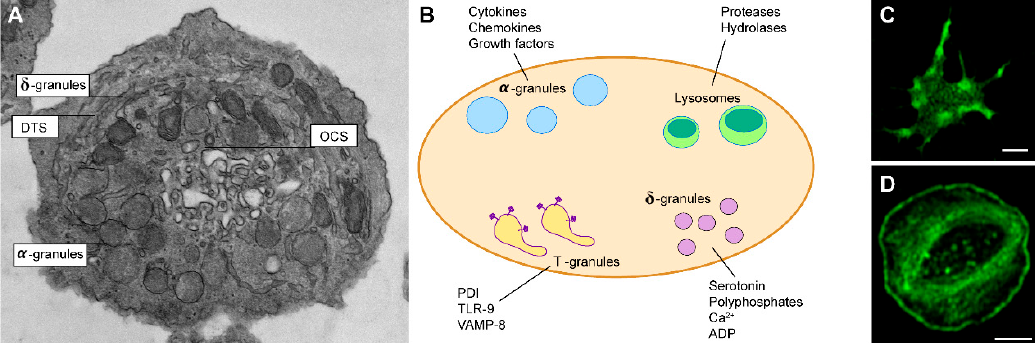
Figure 1. ( A ) Electron micrograph of resting platelet. Indicated: open canalicular system (OCS), dense tubular system (DTS), α -granules, δ -granules that contain small molecules. ( B ) Graphical representation of the main secretory granules of platelets and their contents. Indicated: protein disulfide isomerase (PDI), with toll-like receptor 9 (TLR), vesicle-associated membrane protein 8 (VAMP-8). ( C ) A platelet forming filopodia and ( D ) a fully spread platelet. Platelets were stained for F-actin with phalloidin-Alexa Fluor 488, and visualized by a confocal laser scanning microscope.